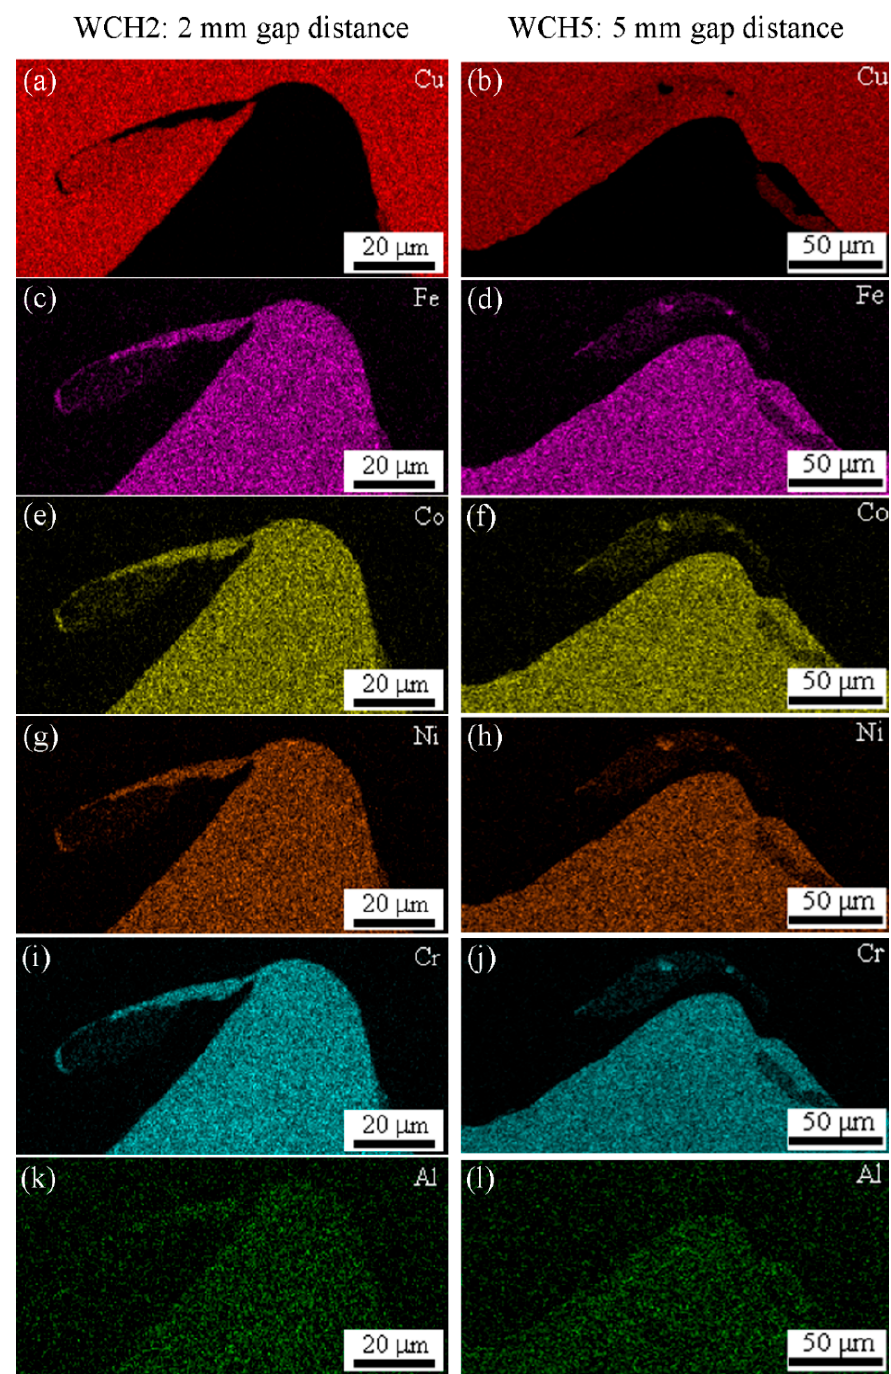
Figure 4. The element mapping of Cu, Fe, Co, Ni Cr and Al on the WCH2 ( a , c , e , g , i , k ) and WCH5 ( b , d , f , h , j , l ) interface.